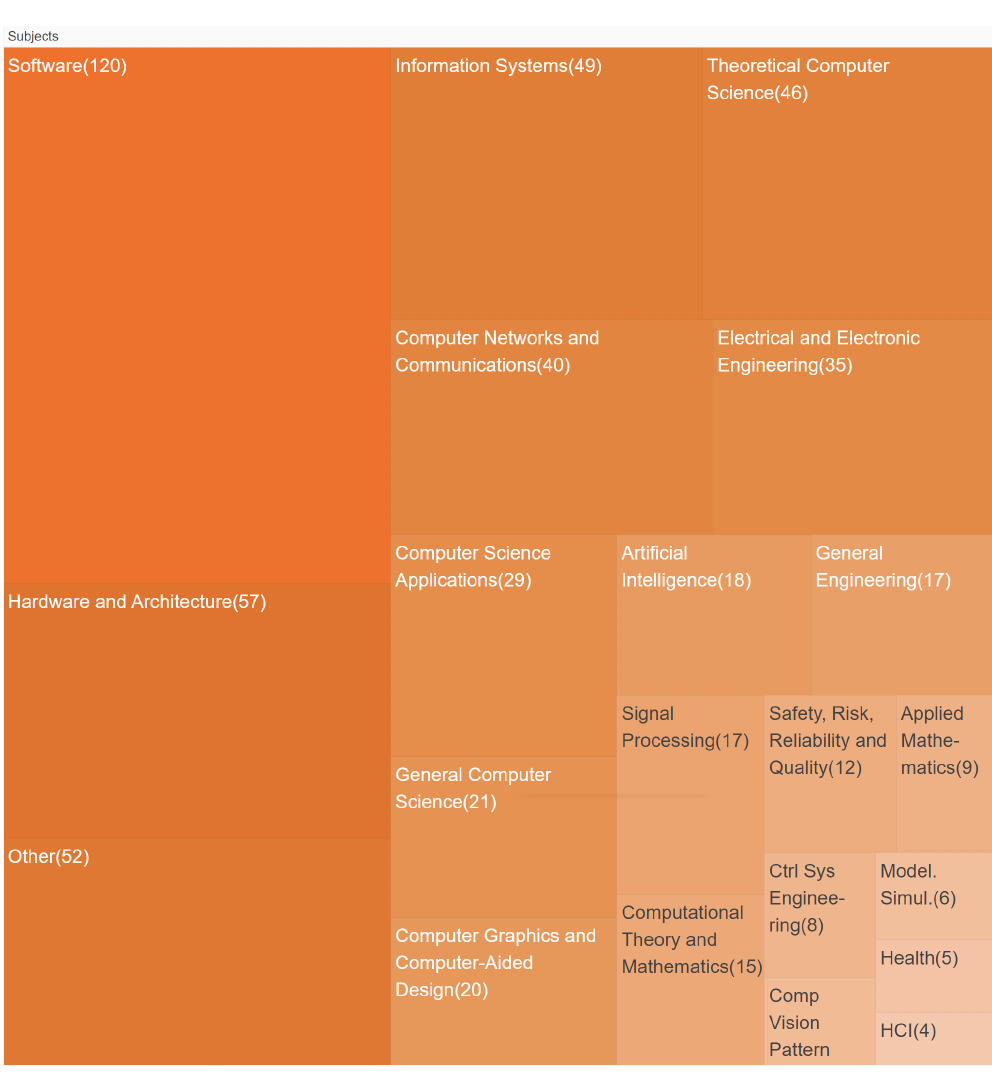
Figure 8. Journal subjects tree